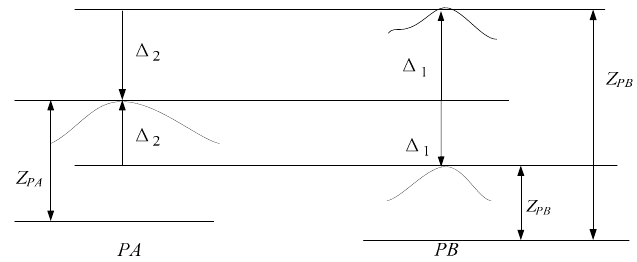
Figure 13. Separation algorithm model of the combined projection curve.